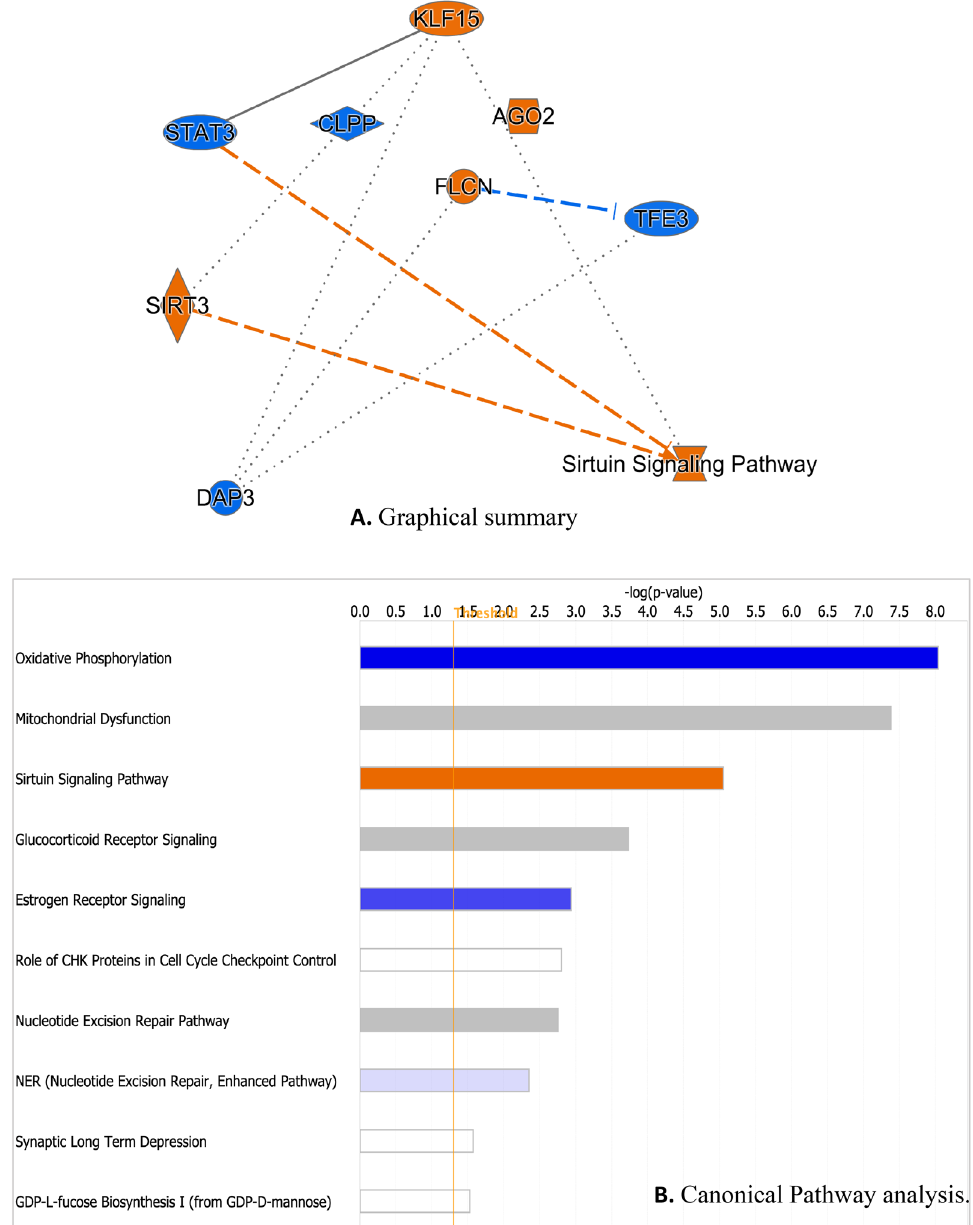
Figure 2. Graphical summary and canonical pathway analysis. ( A ) Graphical summary showing the most significant transcription factors and regulators affected by PNLA. The orange colour goes with the direction of activation while the blue is the inhibition state. ( B ) Canonical pathways bar chart for PNLA effect on activated monocytes. The top 10 most significant pathways are shown, as calculated by Fisher’s exact test right tailed. The colour of the bar is a measure of z-score which reflects the direction of the expression change (pathway activation or inhibition). An orange bar represents an overall positive z-score (majority of genes are upregulated) while a blue bar represents an overall negative z-score (majority of genes are downregulated). White bars possess a z-score which is zero or close to zero. Grey bars highlight pathways for which IPA is unable to make a prediction. The orange line graph represents the ratio (the number of genes that meet cut-off criteria in the dataset, divided by the total number of known genes attributed to that pathway in the IPA reference gene